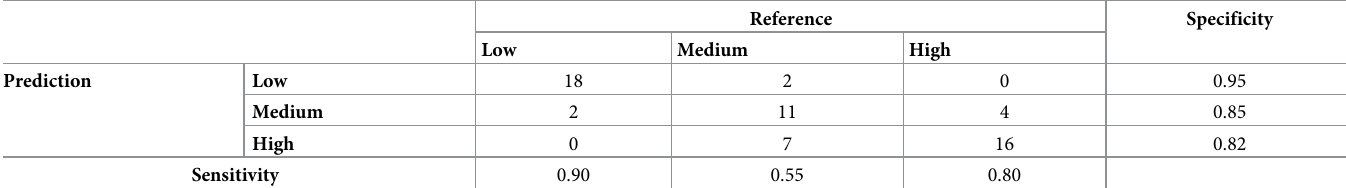
Table 5. Confusion matrix for low (0–10 ton � ha -1 � yr -1 ), medium (10–20 ton � ha -1 � yr -1 ), and high ( > 20 ton � ha -1 � yr -1 ) erosion categories after assesment with